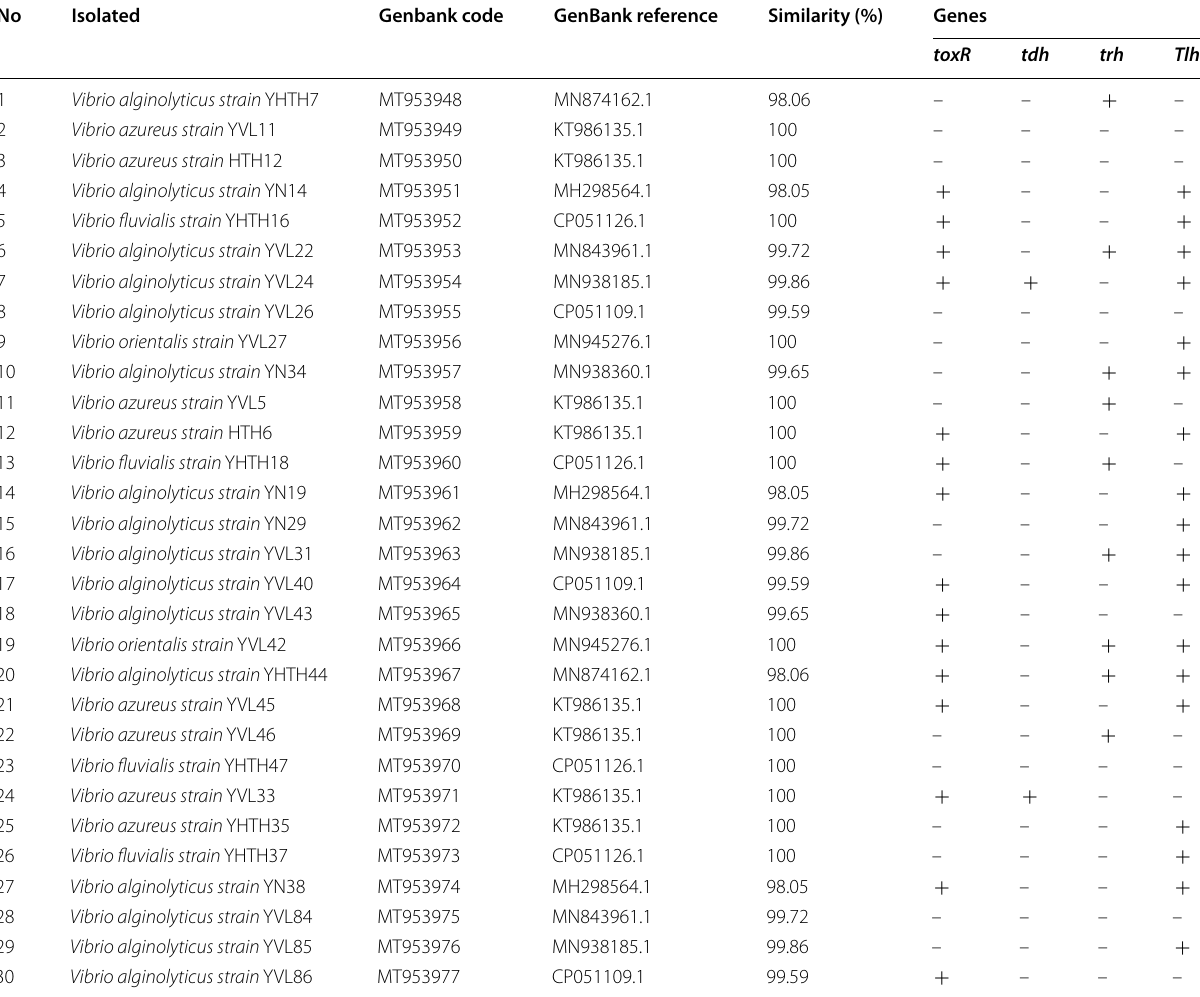
Table 2 Phylogenetic affiliation of isolates on the basis of 16S rRNA gene sequences by using the BLAST program in the GenBank database based on sequence similarity and determination of toxin